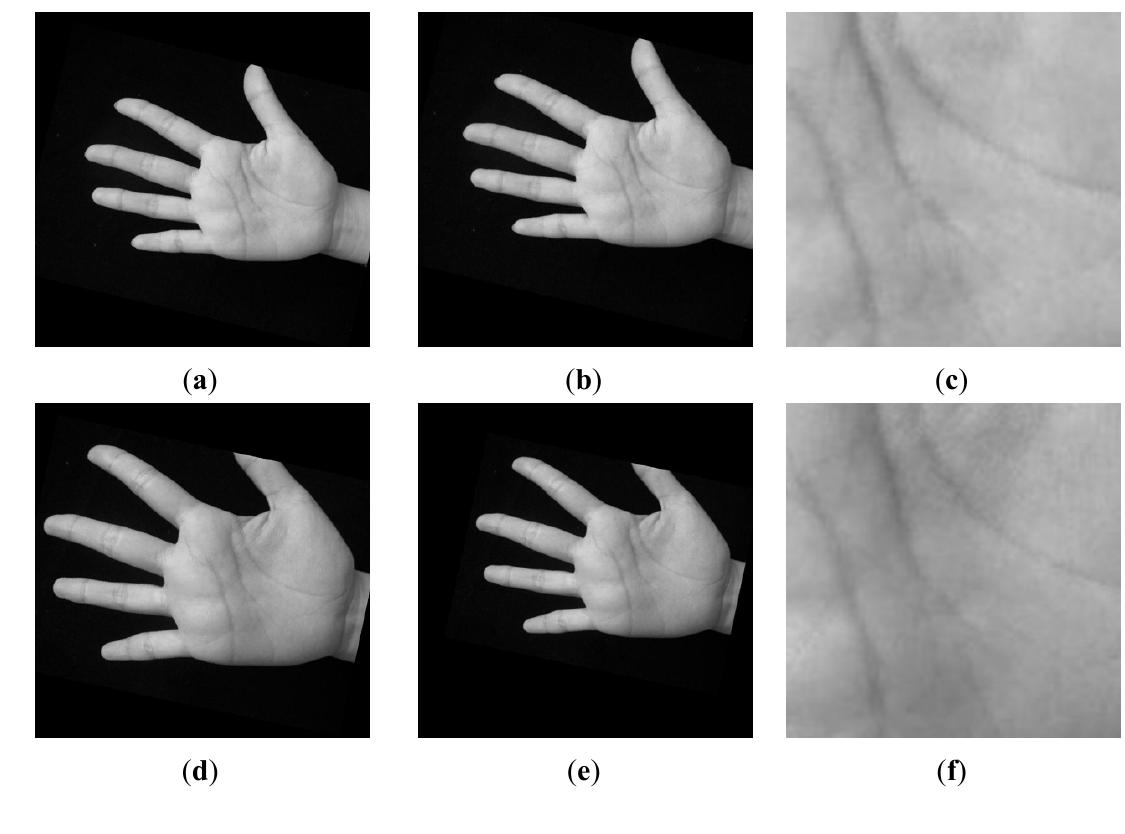
Figure 9. An example of scale normalization: ( a ) and ( d ) two palmprint images with different scales captured from a same palm; ( b ) and ( e ) the scale normalized images of (a) and (d); the ROI images cropped from (b) and